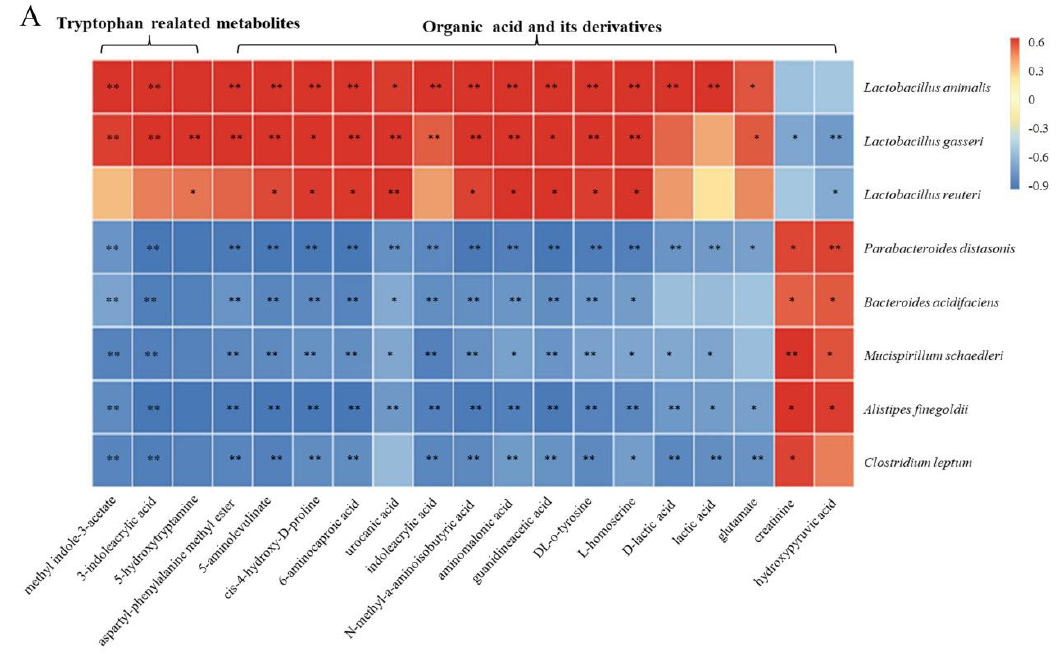
Figure A7. Spearman correlation analysis. ( A ) Correlation analysis between bacterial species and tryptophan-related metabolites, and organic acid and its derivatives. ( B ) Correlation analysis between bacterial species and amino acid and its derivatives. n = 8 for each group. The r value represents the correlation coefficient. * p < 0.05, ** p < 0.01.